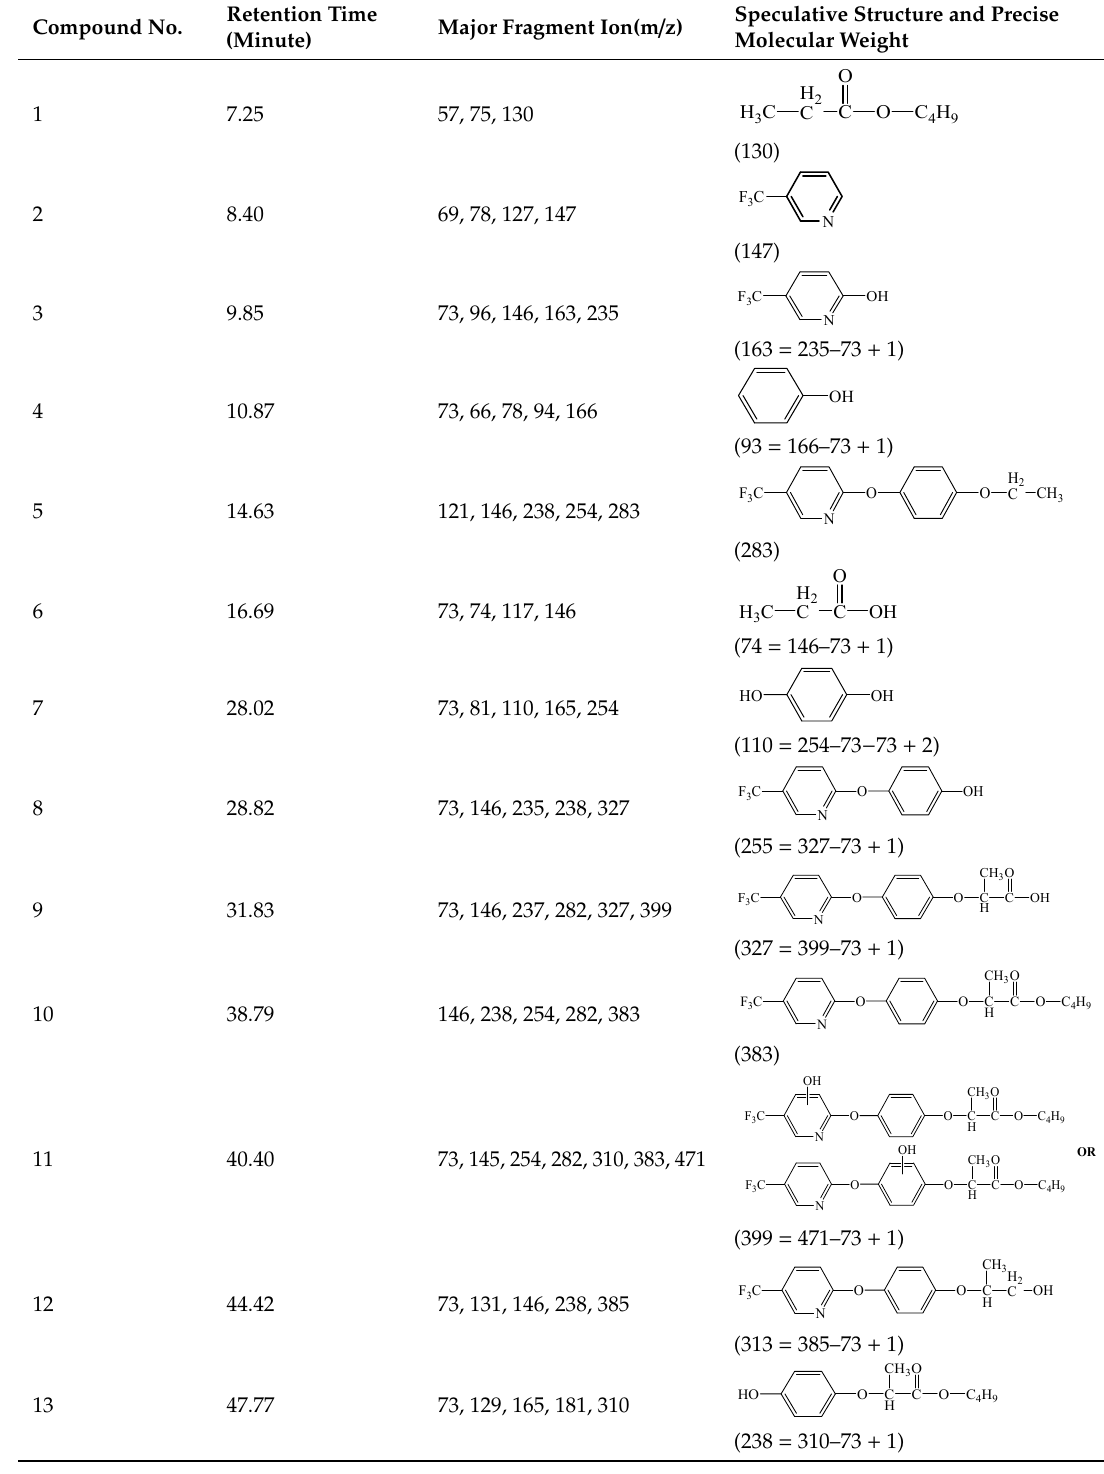
Figure 4. The Total Ion Chromatography (TIC) of derivatized photolytic products of FPB. Table 1. Speculative photolytic products of FPB by nano-TiO 2 mediated.